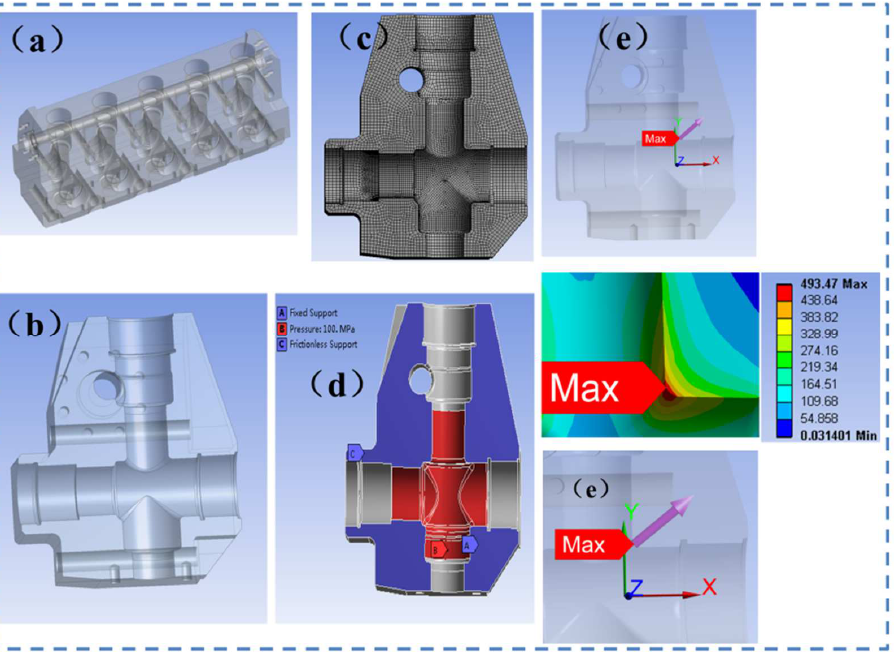
Figure 16. ( a ) Analysis model of the hydraulic part of the fracturing pump, ( b ) 1/2 inner cavity of the pumphead, ( c ) typical mesh structure, ( d ) boundary conditions for numerical simulations, and ( e ) maximum stress contour and focus path.